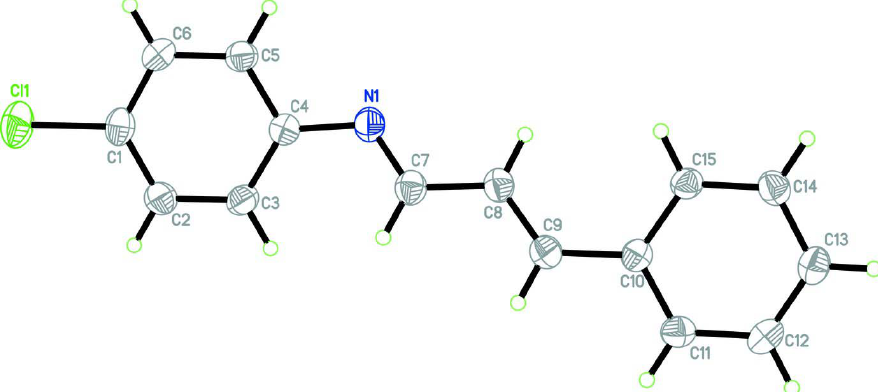
Figure 1 The molecular structure of (I), with displacement ellipsoids drawn at the 30% probability